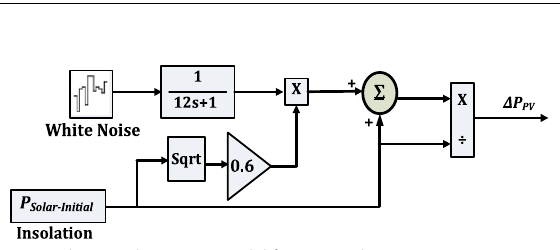
Fig. 4 The PV solar power model for LFC analysis